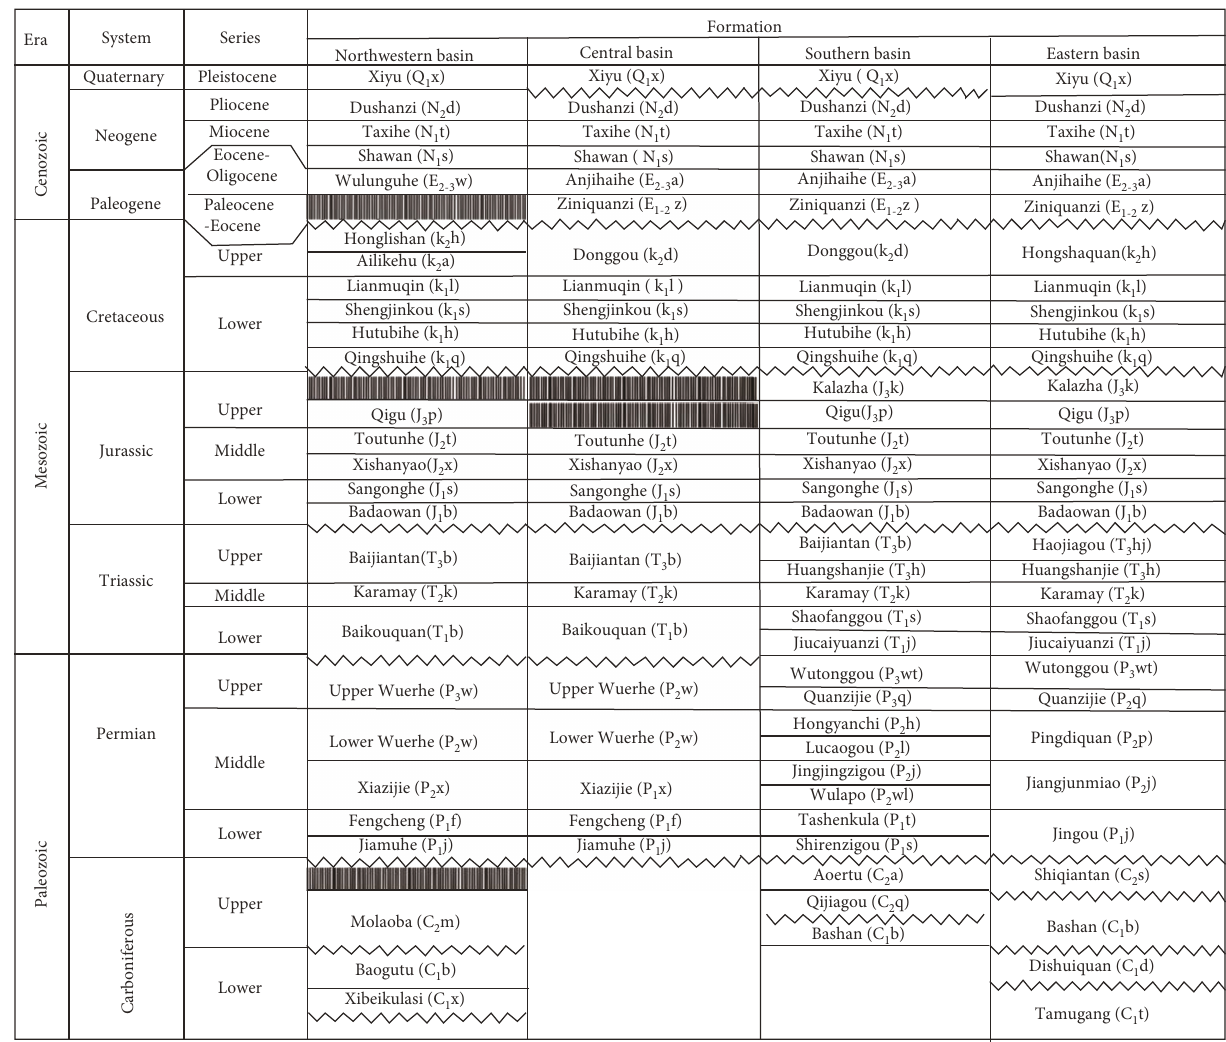
Figure 2: Generalized stratigraphic column in the Junggar Basin (after [76]). Note: the entire lower Cretaceous strata also called the Tugulu group (K tg; 1